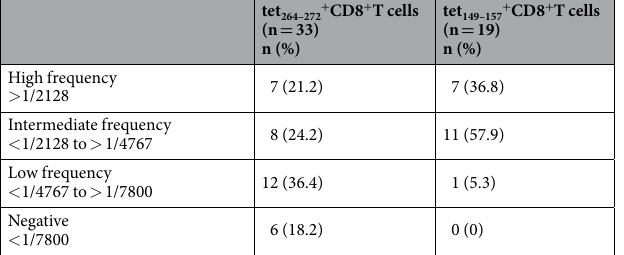
Table 2. Distribution of high, intermediate and low frequency for each tetramer + CD8 + T